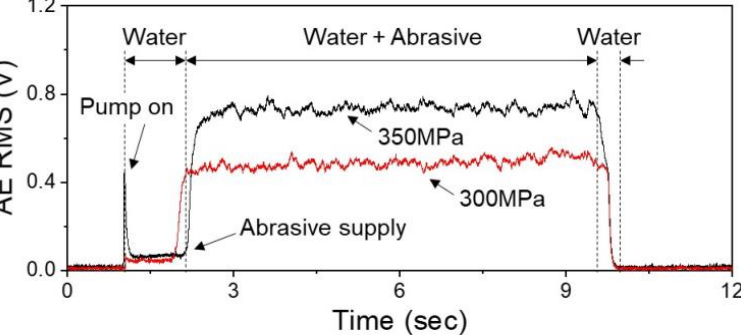
Figure 8. Comparison of AE RMS values as the waterjet pressure varies at 350 g/min of abrasive flow.